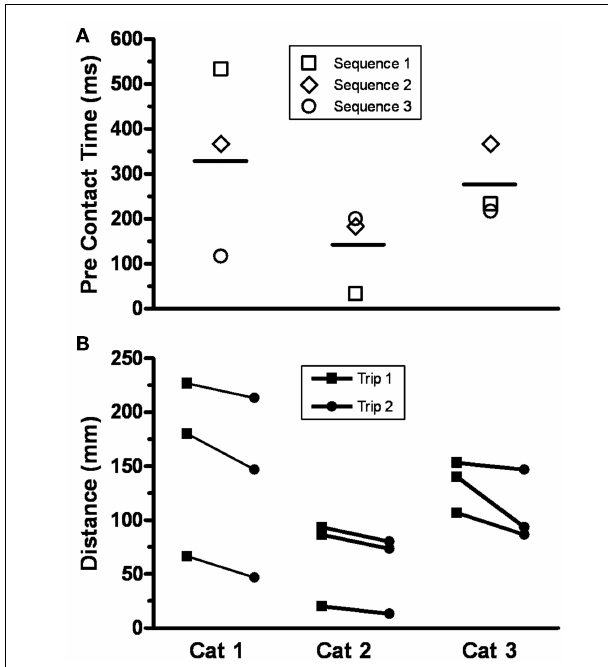
FIGURE 4 | (A) The pre-contact time, defined as the time when the foot started to lift prior to contact with the trip rod, forTrip 2 compared toTrip 1 for three sequences is shown for three cats.The horizontal bar is the mean for three sequences for each cat (range, 150–350ms). A shorter pre-contact time forTrip 2 thanTrip 1 was present in all nine cases. (B) The distance from toe off to contact with the trip rod forTrip 1 andTrip 2 for three sequences is shown for the same three cats. All distances were shorter for Trip 2 thanTrip 1.